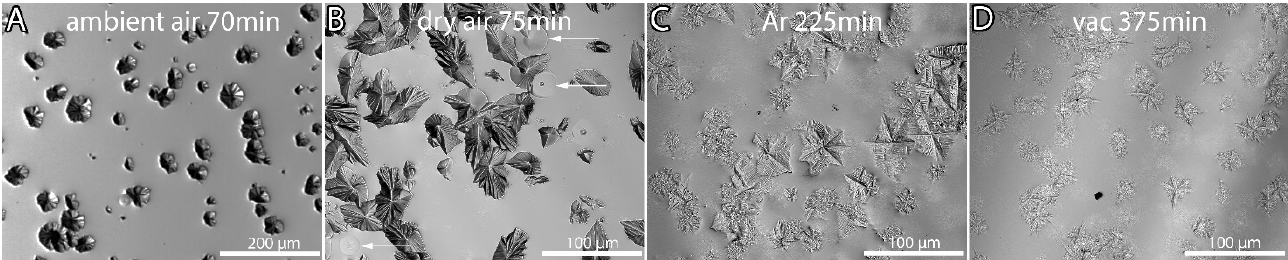
Figure 2. LSM overview images showing that the crystals in Figure 1 are representative.